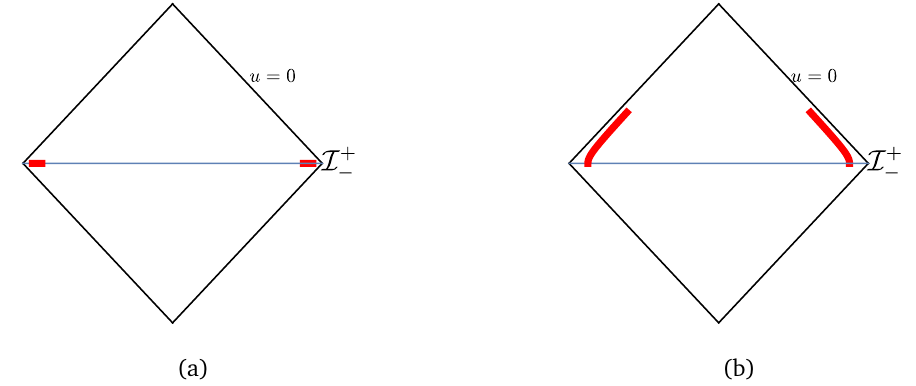
Figure 6: Our protocol (left) reduces quantum fluctuations by averaging over the radial direction. This allows us to associate asymptotic charges at the metric over the thick red region. In particular, we avoid having to smear the + (right), which would have made the asymptotic metric up to a finite value of u on I + charges ill-defined at − I